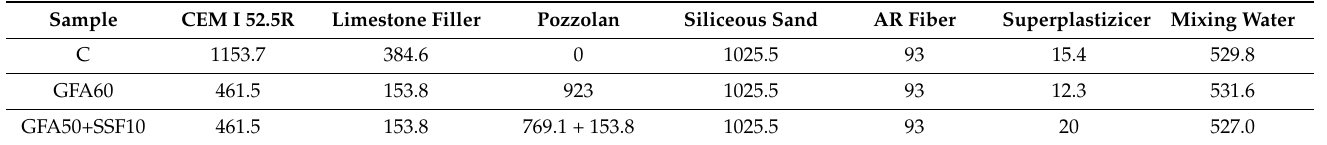
Table 4. Dose of the manufactured GRC mortars (values in